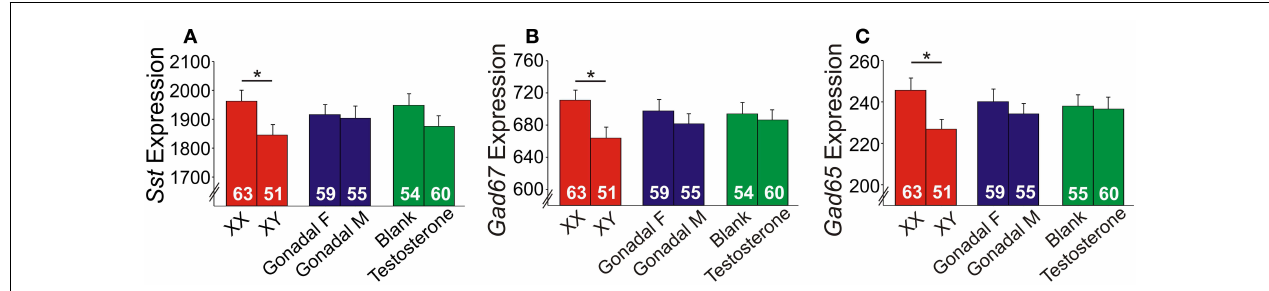
FIGURE 5 | Expression of GABA-related genes in the frontal cortex of FCG mice . XY mice had lower (A) Sst , (B) Gad67 , and (C) Gad65 expression levels compared to XX mice. Error bars indicated mean ± SEM. * p < 0.05. Y -axis, truncated arbitrary expression units.